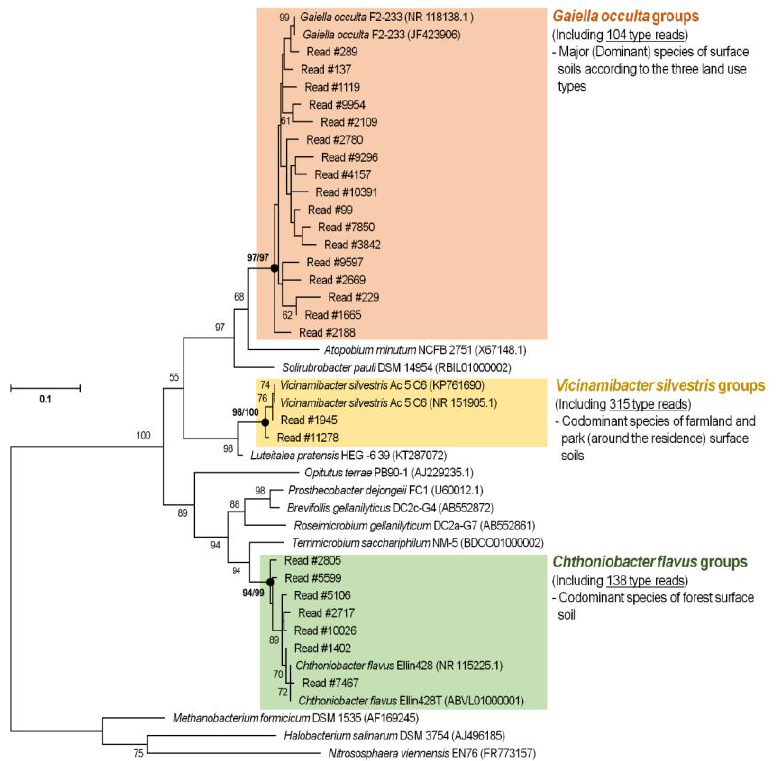
Figure 3. Maximum likelihood (using the Tamura-Nei distance model) tree showing the phyloge- netic position of major and codominant species from topsoil of three land use types based on 16S rRNA gene sequences. Closed circle indicates corresponding branches recovered in the maximum likelihood/neighbor-joining (using the Kimura 2-parameter distance model) trees. Bootstrap values less than 50% based on 1000 replications are shown. Three archaea [ Methanobacterium formicicum DSM 1535 (AF169245), Halobacterium salinarum DSM 3754 (AJ496185), and Nitrososphaera viennensis EN76 (FR773157)] were used as an out group. Bar, 0.1 nucleotide